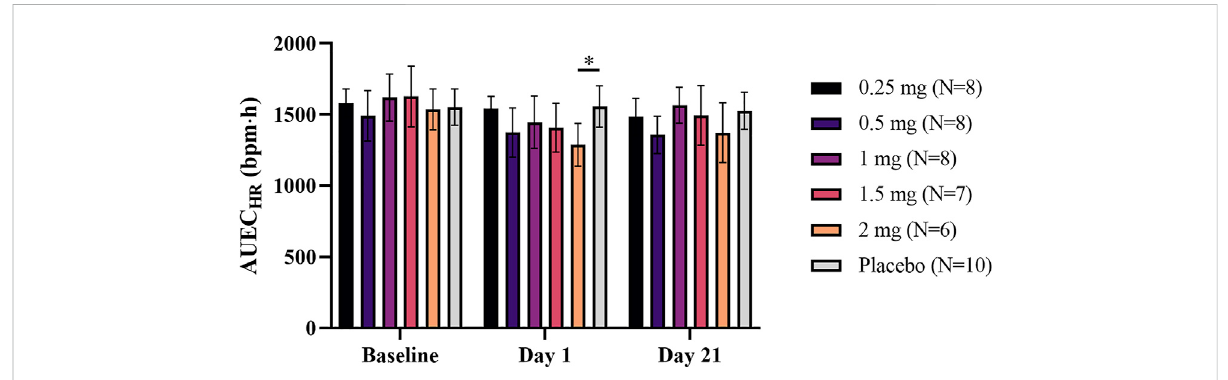
FIGURE 4 Meanareaundereffectcurveofhourlyaverageheartrateatthebaseline,aftersingleanddailyoraladministrationof0.25,0.5,1,1.5,and2 mgof LC51-0255 for 21 days. Notes: Error bars denote the standard deviations; p p < 0.05, LC51-0255 2 mg versus placebo at day 1.